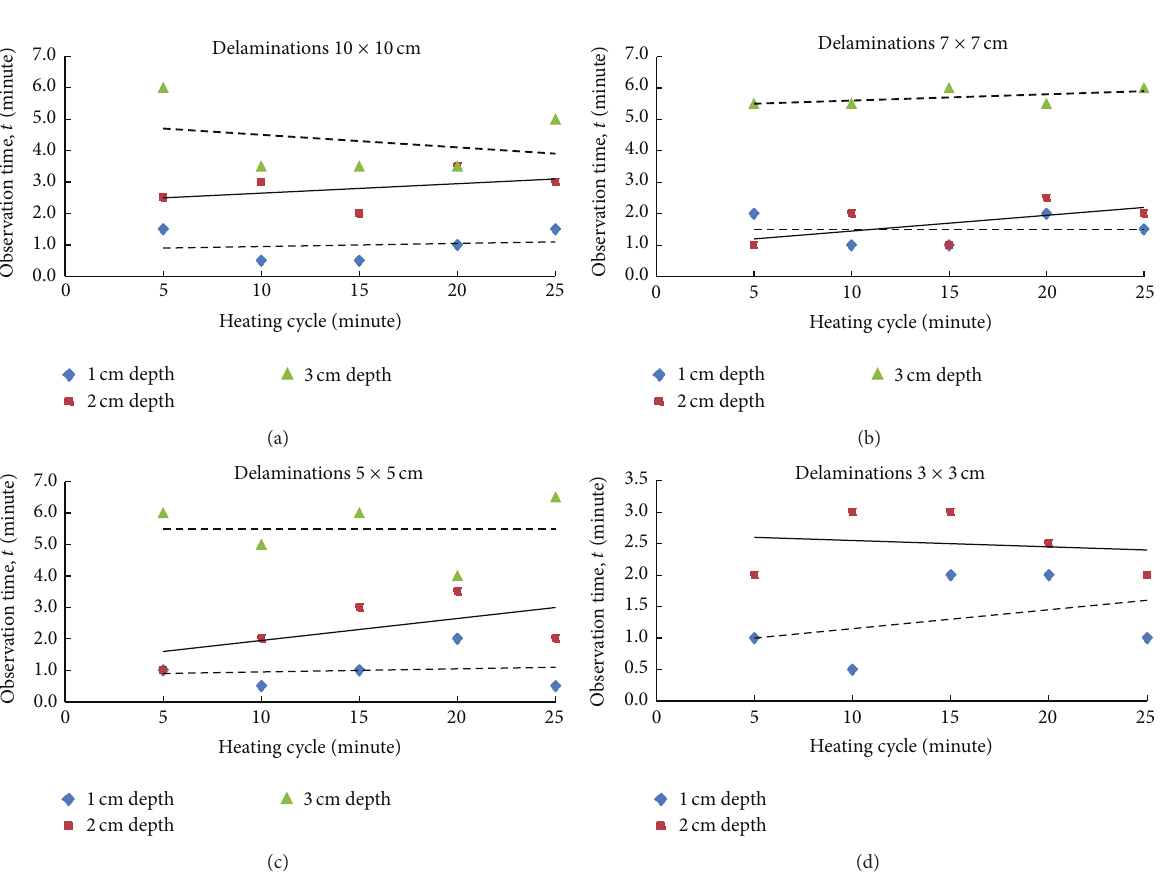
Figure 13: Relationship between the observation time and heating cycles for the delaminations of sizes: (a) 10 × 10cm, (b) 7 × 7 cm, (c) 5 × 5 cm, and (d) 3 × 3